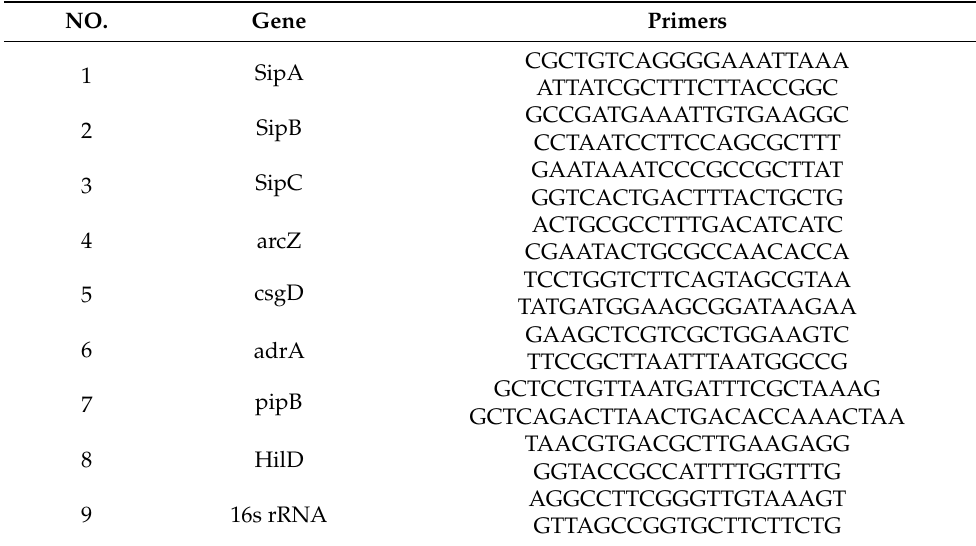
Table 1. Primers used in